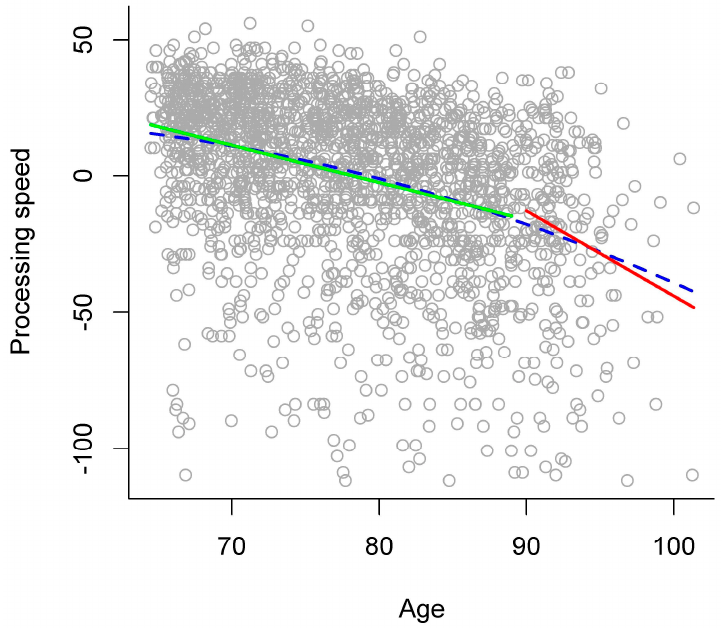
Figure 1. Age relations in processing speed. Scores in processing speed plotted against chronological age, with different models of age relations: gradual model (blue dashed line) and stage model (young-old adults: green solid line, versus old-old adults: red solid line). Note that to achieve that higher values represented better performance across all variables, the distribution of latency scores was reversed. Individuals with negative values were slower than the mean.